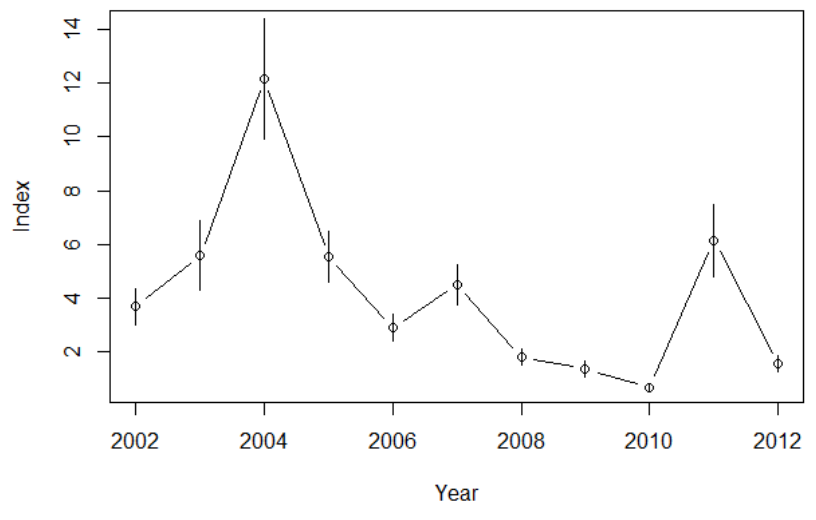
Figure 24. Index of relative abundance of male horseshoe crabs (delta mean crabs per sampling event) developed from the spring portion of New Hampshire’s Spawning Beach Survey with 95% confidence